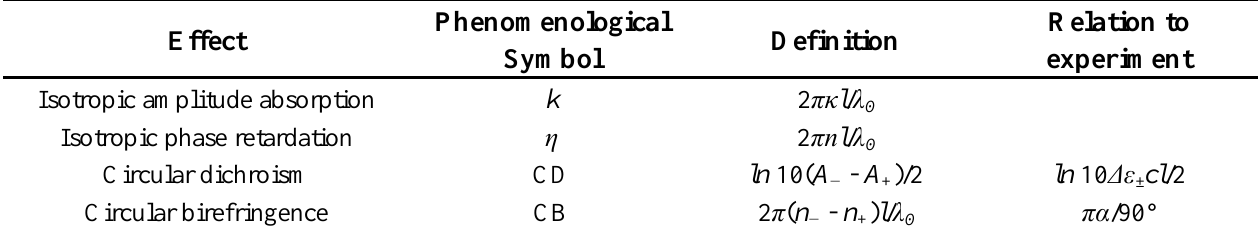
Table 1. Notations and conventions in anisotropic spectroscopy